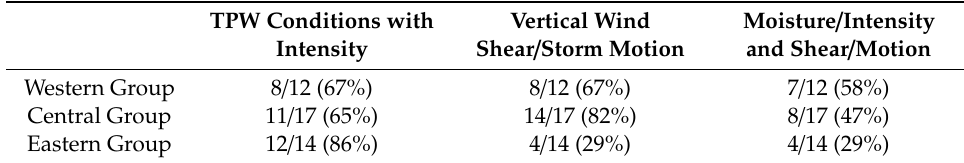
Table 6. The percentage of storms’ rainfall patterns that can be explained by TPW distribution or vertical wind shear and storm motion. TPW Conditions with Vertical Wind Moisture / Intensity Intensity Shear / Storm Motion and Shear /